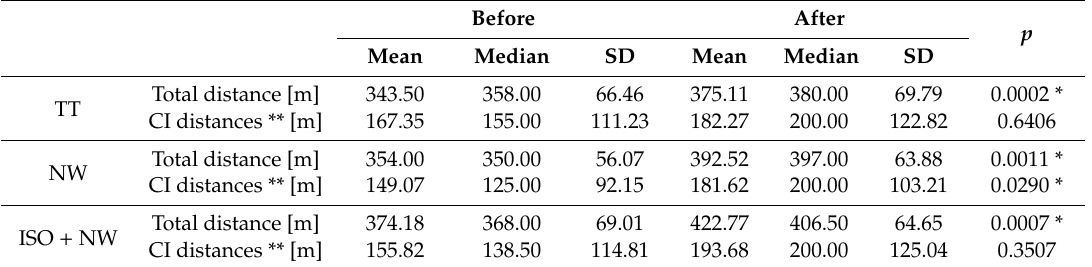
Table 9. Total distance and intermittent claudication (CI) distance values during the 6-Minute Walk